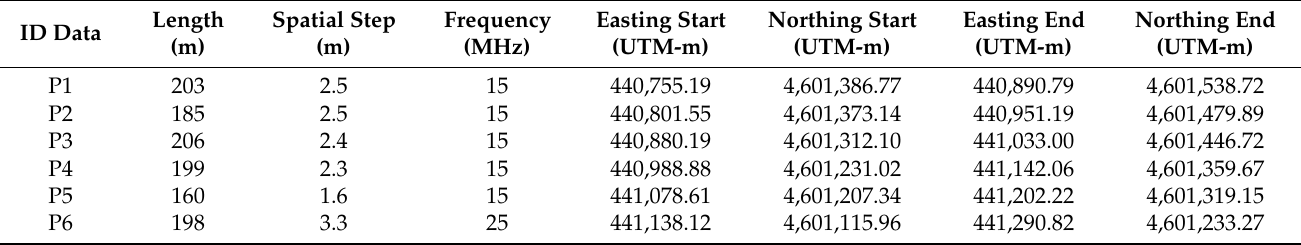
Table 2. Acquisition parameters of the GPR